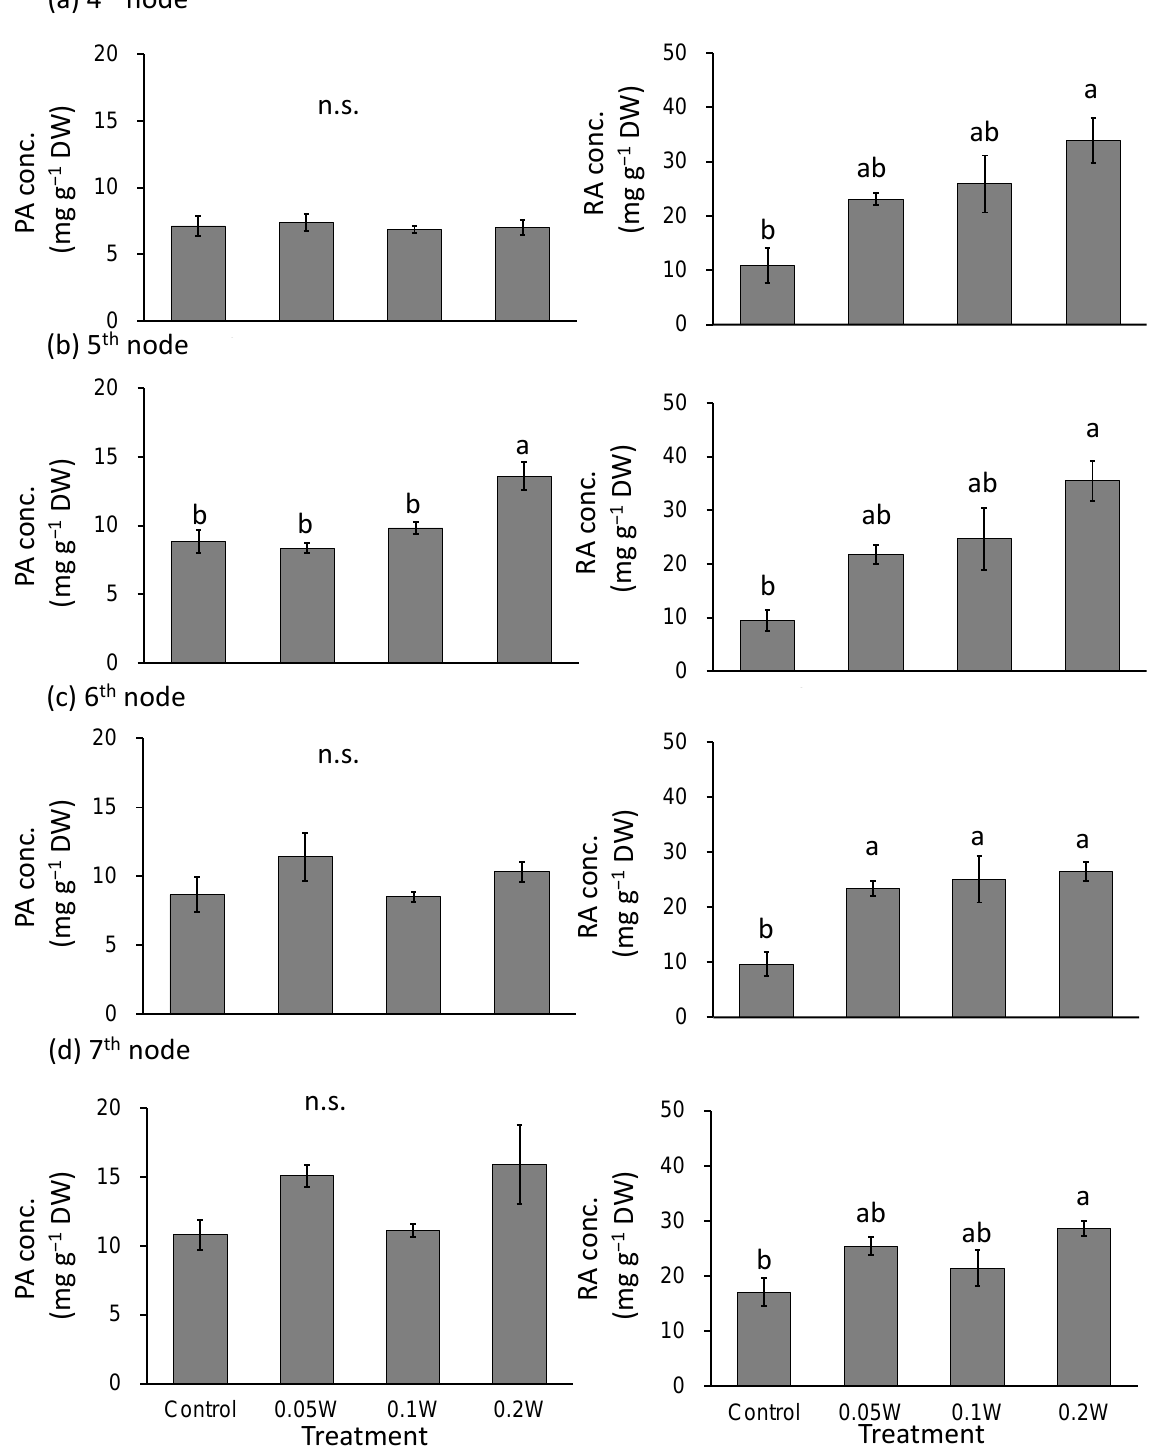
Figure 6. Effect of exposure to 3 h of nocturnal UV-B lighting on phytochemical (perillaldehyde (PA), rosmarinic acid (RA)) concentrations (Experiment 2). Perilla plants were irradiated for 3 h from 02:00 to 05:00 in all UV-B light treatments. The UV-B radiation intensity at the plant canopy level was set to 0.05, 0.1, or 0.2 W m − 2 . The integrated UV-B energy at 0.05, 0.1, and 0.2 W m − 2 was 0.54, 1.0 and 2.2 kJ m − 2 day − 1 , respectively. Leaves at the 4th node counted from the bottom of the main stem were harvested 1 week after treatment initiations; thereafter, leaves at the 5th, 6th, and 7th nodes were sampled from the same plants at 2, 3, and 4 weeks after treatment initiation. Vertical bars indicate SE ( n = 4). Different letters indicate significant difference among treatments at p < 0.05, and n.s. indicates no significant difference as per the Tukey-Kramer